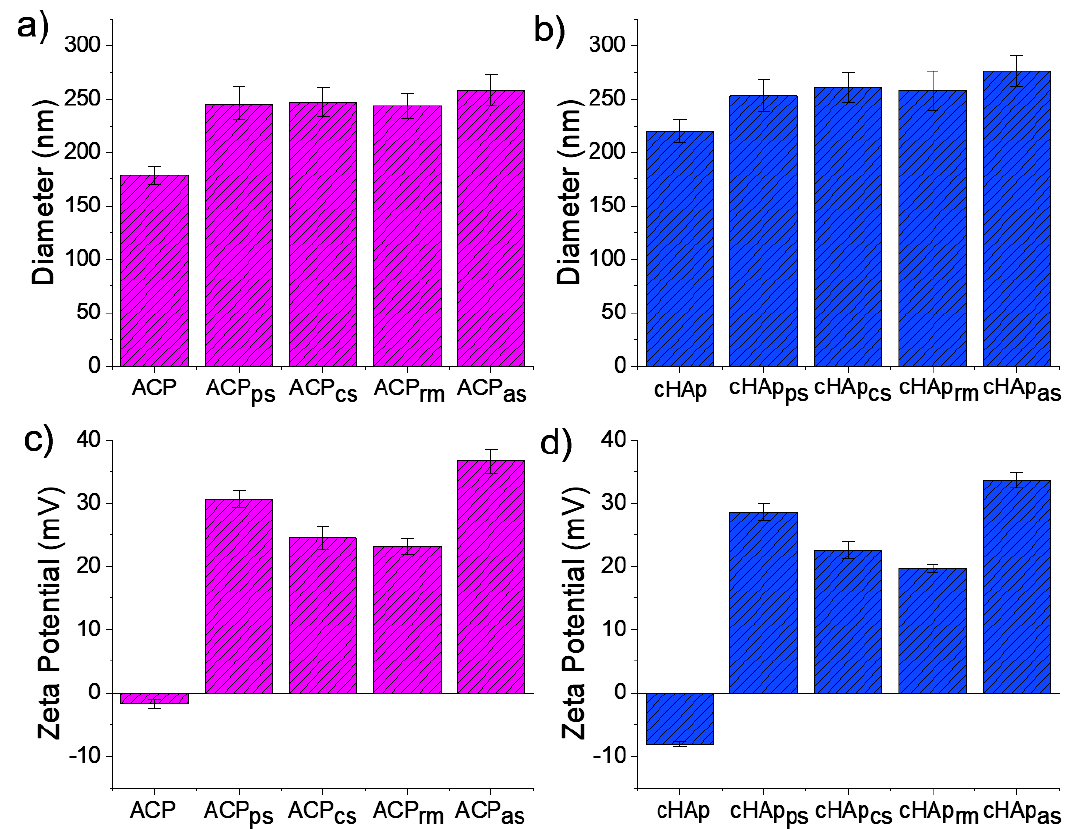
Figure 3. Hydrodynamic size ( a , b ) measured by dynamic light scattering (DLS) and Zeta-potential ( c , d ) for unloaded and STR-loaded ACP ( a , c ; red bars) and cHAp ( b , d ; blue bars) nanoparticles.